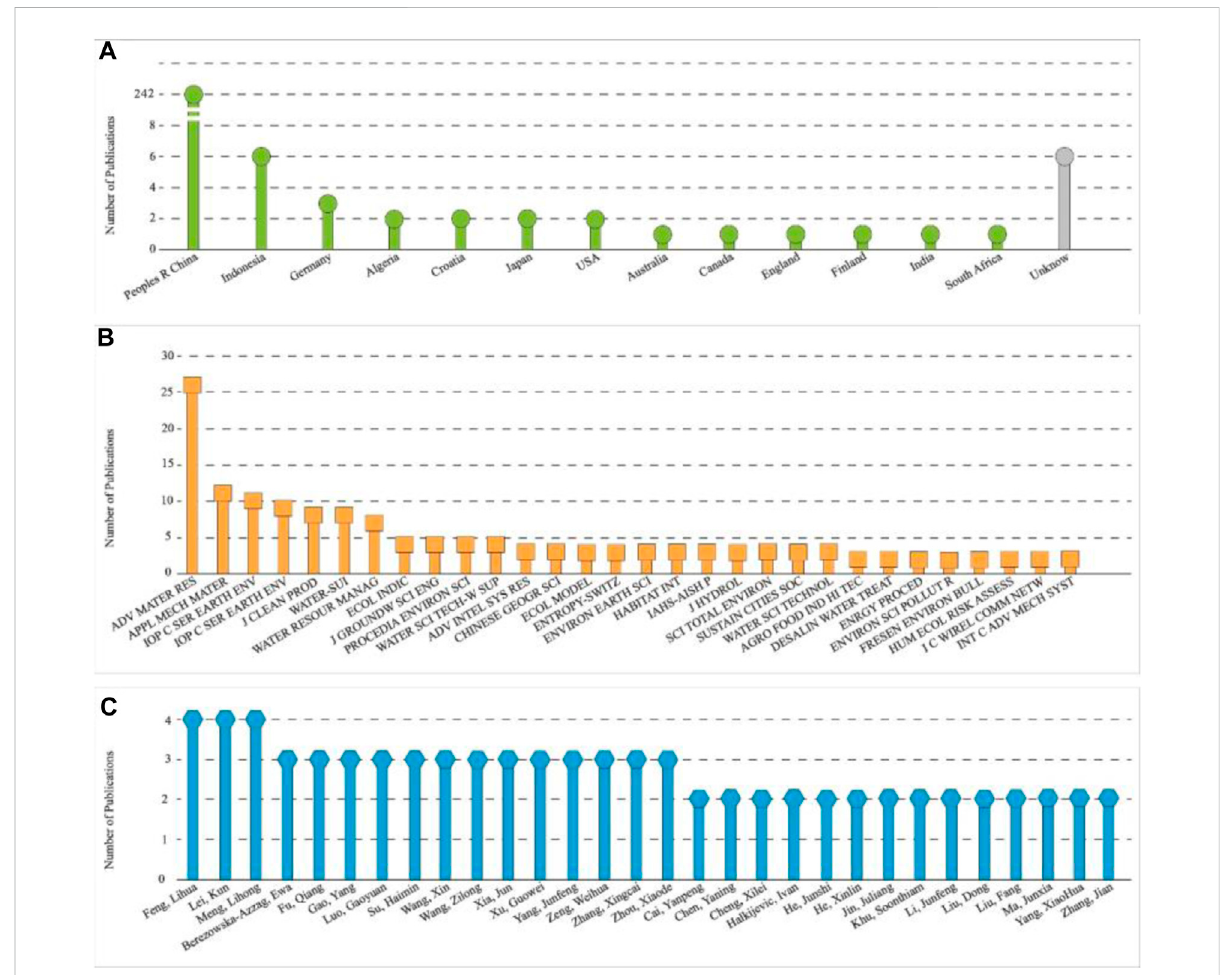
FIGURE 3 Number of articles published by countries, periodicals, and